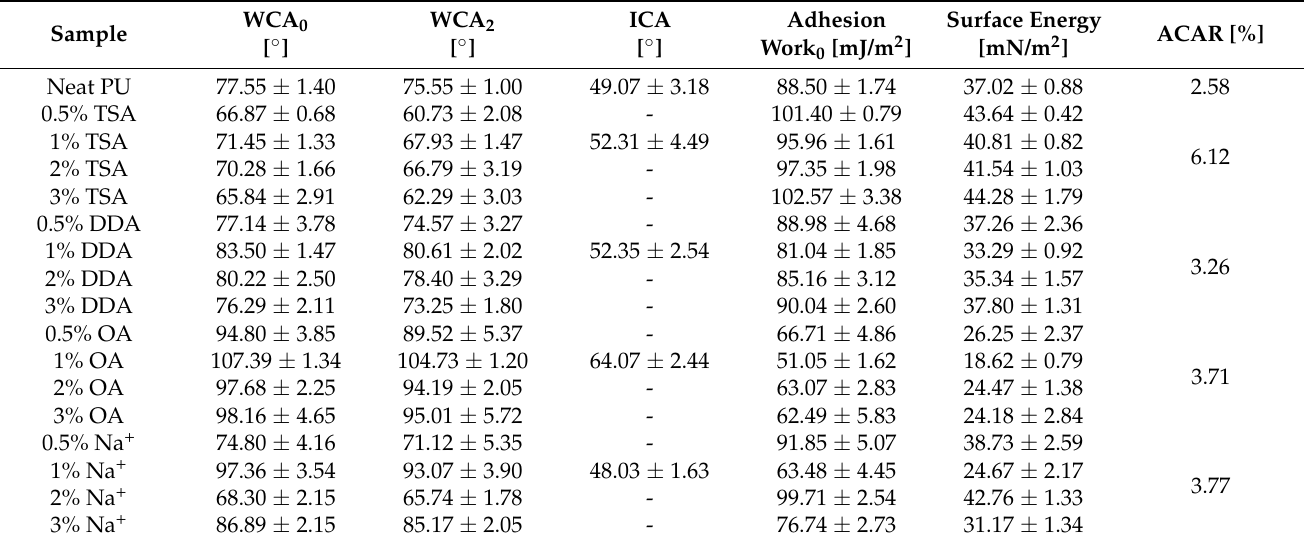
Table 6. Wetting properties: water contact angle at 0 min (WCA 0 ), water contact angle at 2nd